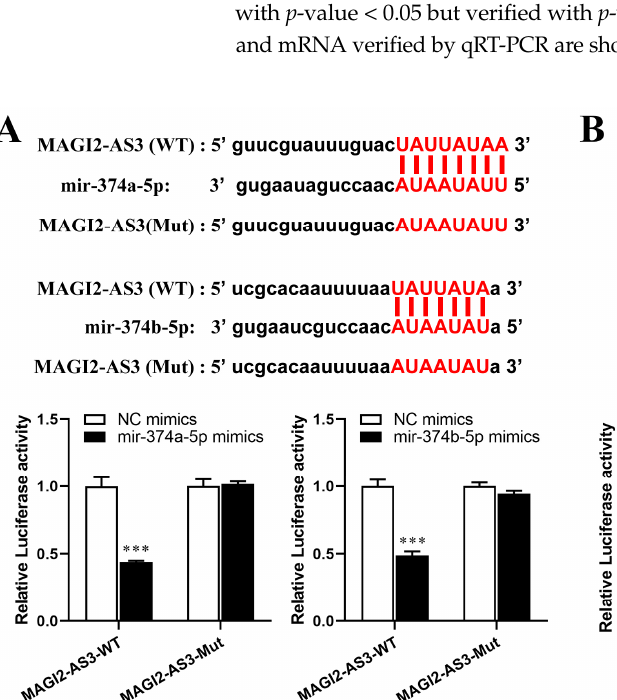
Figure 7. ( A ) Sequences of MAGI2-AS3/miR-374a/b-5p binding site predicted by StarBase 2.0. MiR- 374a/b-5p mimics only reduced MAGI2-AS3-wt luciferase activity. ( B ) Sequences of miR-374a/b-5p /FOXO1 binding site predicted by StarBase 2.0. MiR-374a-5p/miR-374b-5p mimics only reduced FOXO1-wt luciferase activity. ( C ) QRT-PCR shows that MAGI2-AS3 and FOXO1 expression were increased and miR-374a/b-5p was decreased, and western blot results showed that FOXO1 protein level was increased due to overexpression of MAGI2-AS3. ( D ) QRT-PCR results showed that mRNA levels of MAGI2-AS3 and FOXO1 expression were decreased and miR-374a/b-5p was increased, and western blot results showed that the FOXO1 protein level was decreased due to the inhibition of MAGI2-AS3. * p < 0.05, ** p < 0.01, *** p < 0.001. MAGI2-AS3, MAGI2 antisense RNA 3. WT, wild type. Mut, mutant. FOXO1, Forkhead Box O1.QRT-PCR, quantitative real-time polymerase chain reaction. 3.5. CeRNA Effector FOXO1 Regulates Proliferation, Migration, Invasion, and Apoptosis In Vitro In order to explore the biological function of FOXO1 on HepG2 cells, we constructed an overexpression lentiviral vector of FOXO1 and designed siRNA to reduce the expres- sion of FOXO1.. QRT-PCR and western blot showed that the expression of FOXO1 mRNA and protein was significantly upregulated in HepG2 cells with the overexpression of FOXO1 (Figure 8A,B). QRT-PCR and western blot also showed that the expression of FOXO1 mRNA and protein was significantly downregulated in HepG2 cells with si-